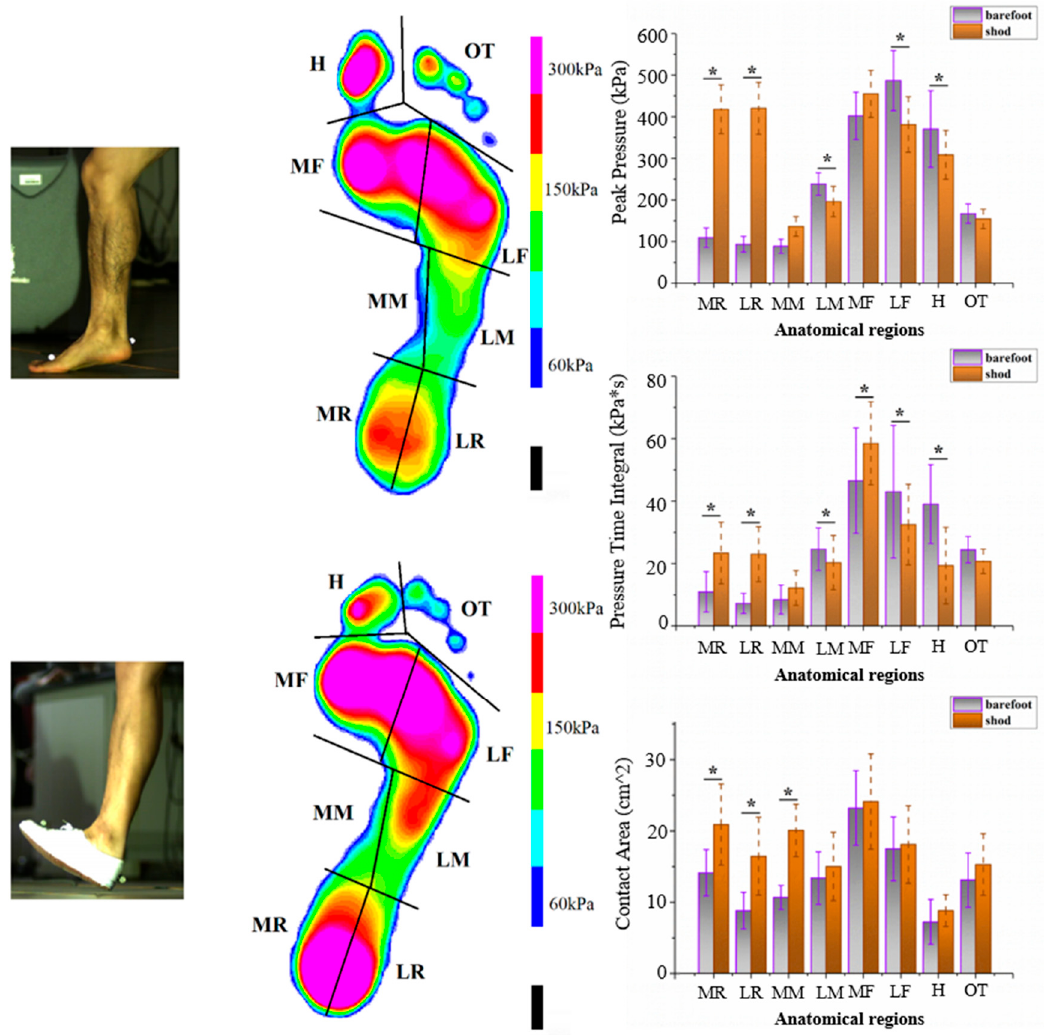
Figure 3. Foot pressure of barefoot and shod running. Medial rearfoot (MR), lateral rearfoot (LR), medial midfoot (MM), lateral midfoot (LM), medial forefoot (MF), lateral forefoot (LF), hallux (H), and other toes (OT). * indicates significance, p < 0.05.